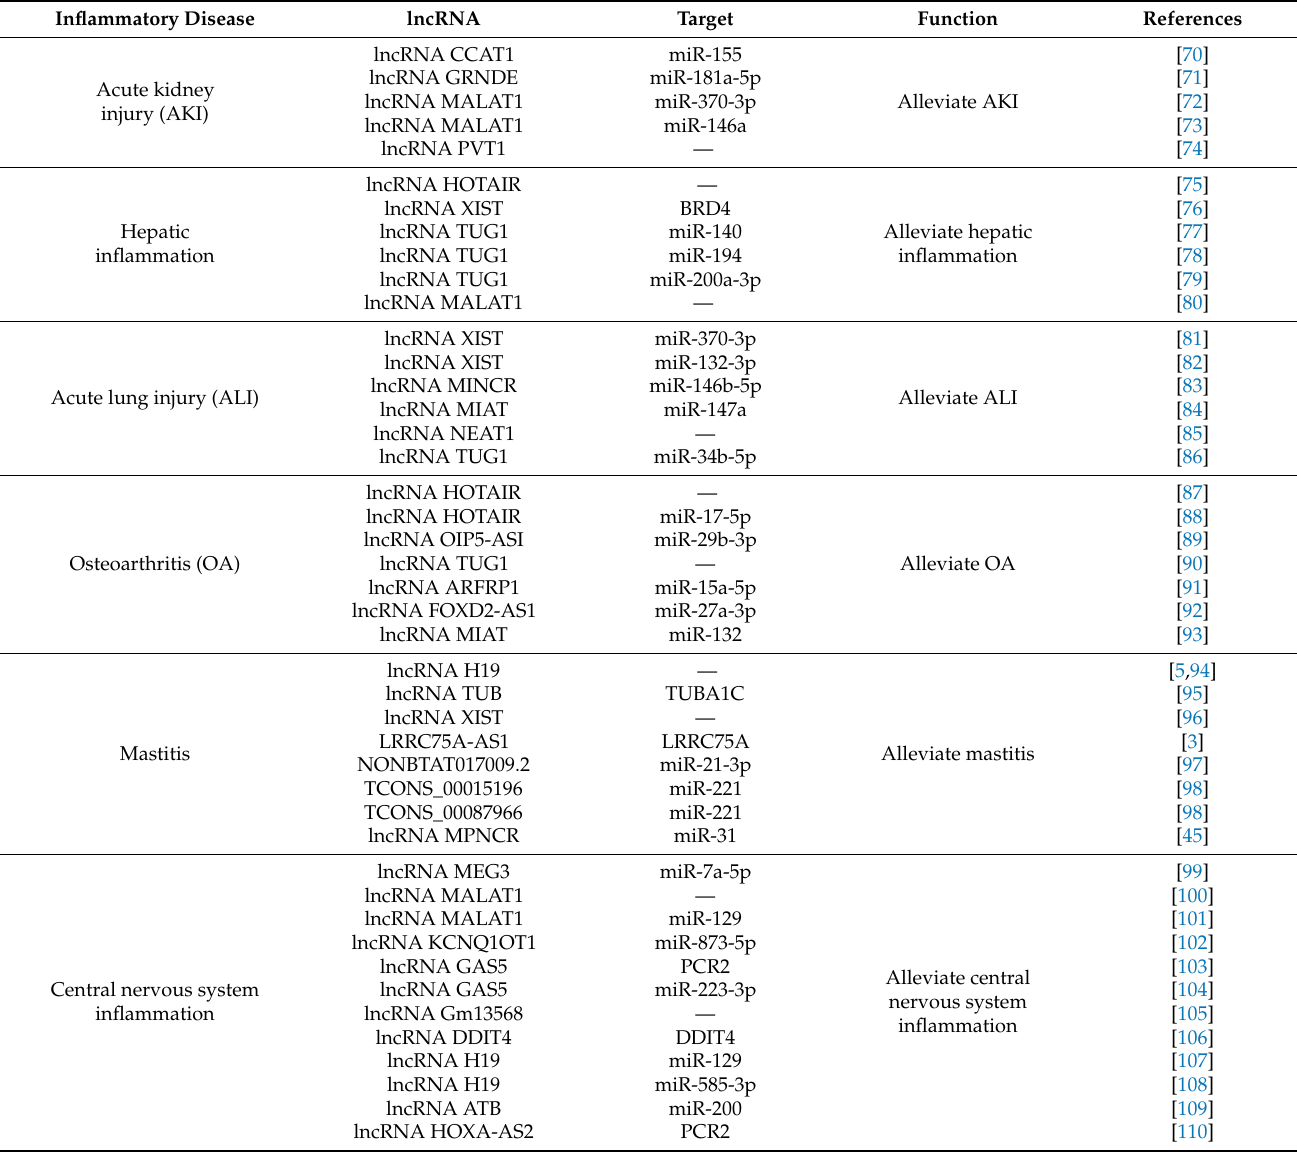
Table 2. Function of long noncoding RNAs in various inflammatory